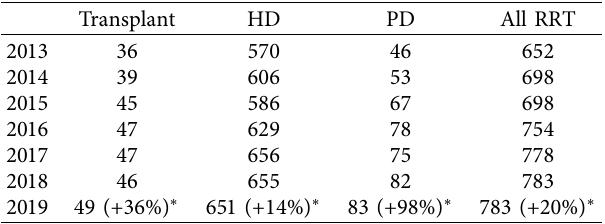
Table 5: Modalities of RRT in Brunei and percentage increases since